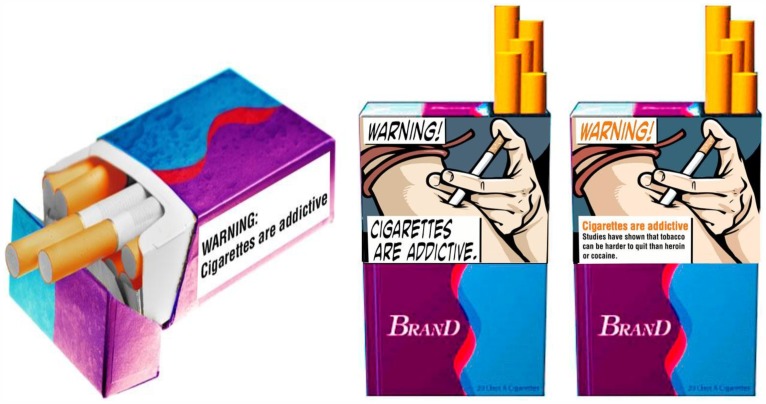
Examples of warning labels with (A) text on side of pack, (B) picture and text on front of pack, and (C) picture, text and elaboration on front of pack.Reprinted from www.fda.gov under a CC BY license, with permission from the FDA, copyright 02/24/2012.